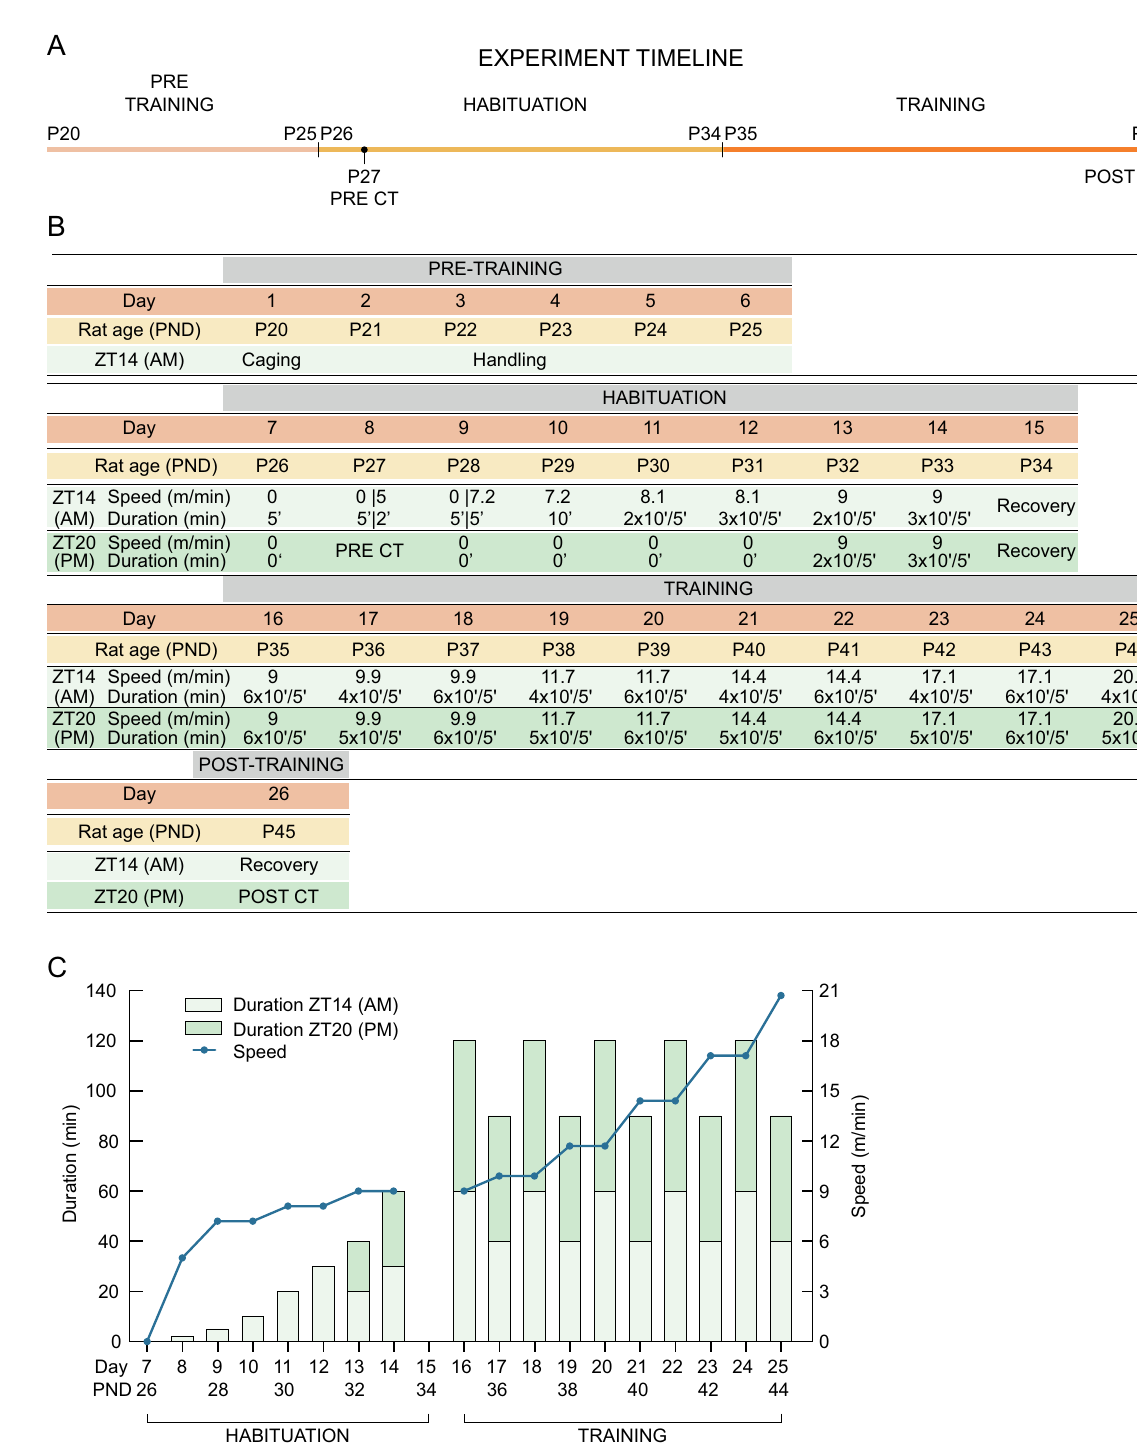
Figure 1. Forced wheel exercise schedule and protocol. ( A ) Experiment timeline. ( B ) Forced exercise schedule and protocol. The training program was divided in 4 steps, namely Pre-training, Habituation, Training and Post- training. The duration of the exercise was split in bouts of 10 min, with a resting period of 5 min between bouts. ( C ) Representation of the duration (bars) and speed (line) of the training